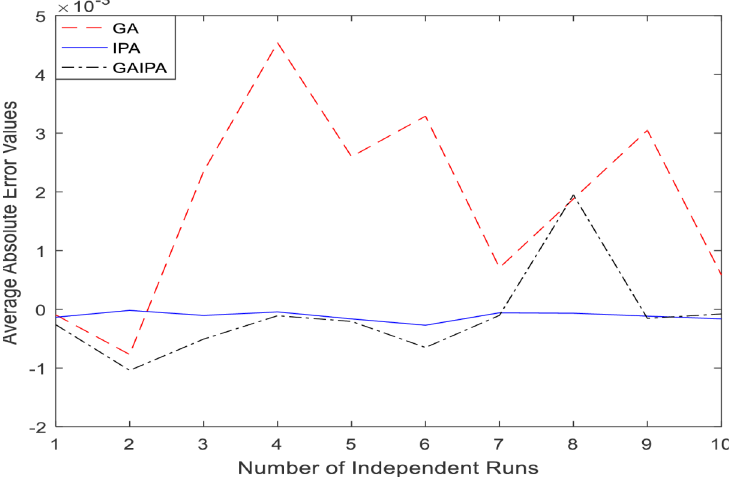
Fig 2. Graphical representation of average absolute errors for Example #01 when δ = 2.0 using Log Sigmoid.